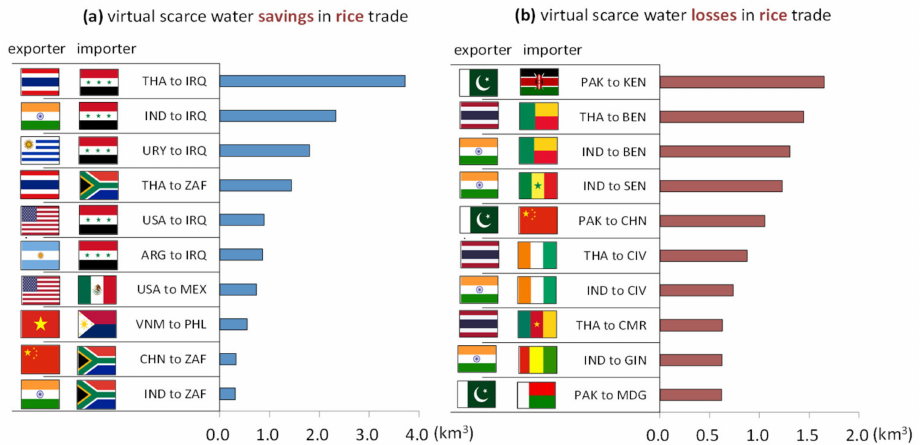
Figure 4. Top 10 rice trades of virtual scarce water ( a ) savings and ( b ) losses (the average during 2008 to